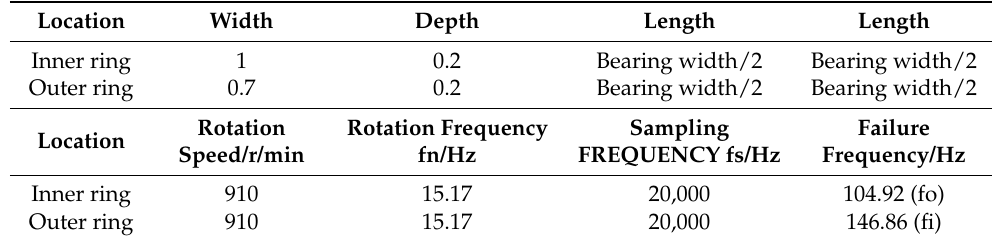
Table 2. Fault bearing parameters.